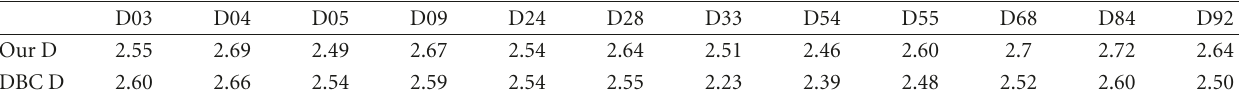
Figure 11: Texture images. Table 10: Estimated FD of texture